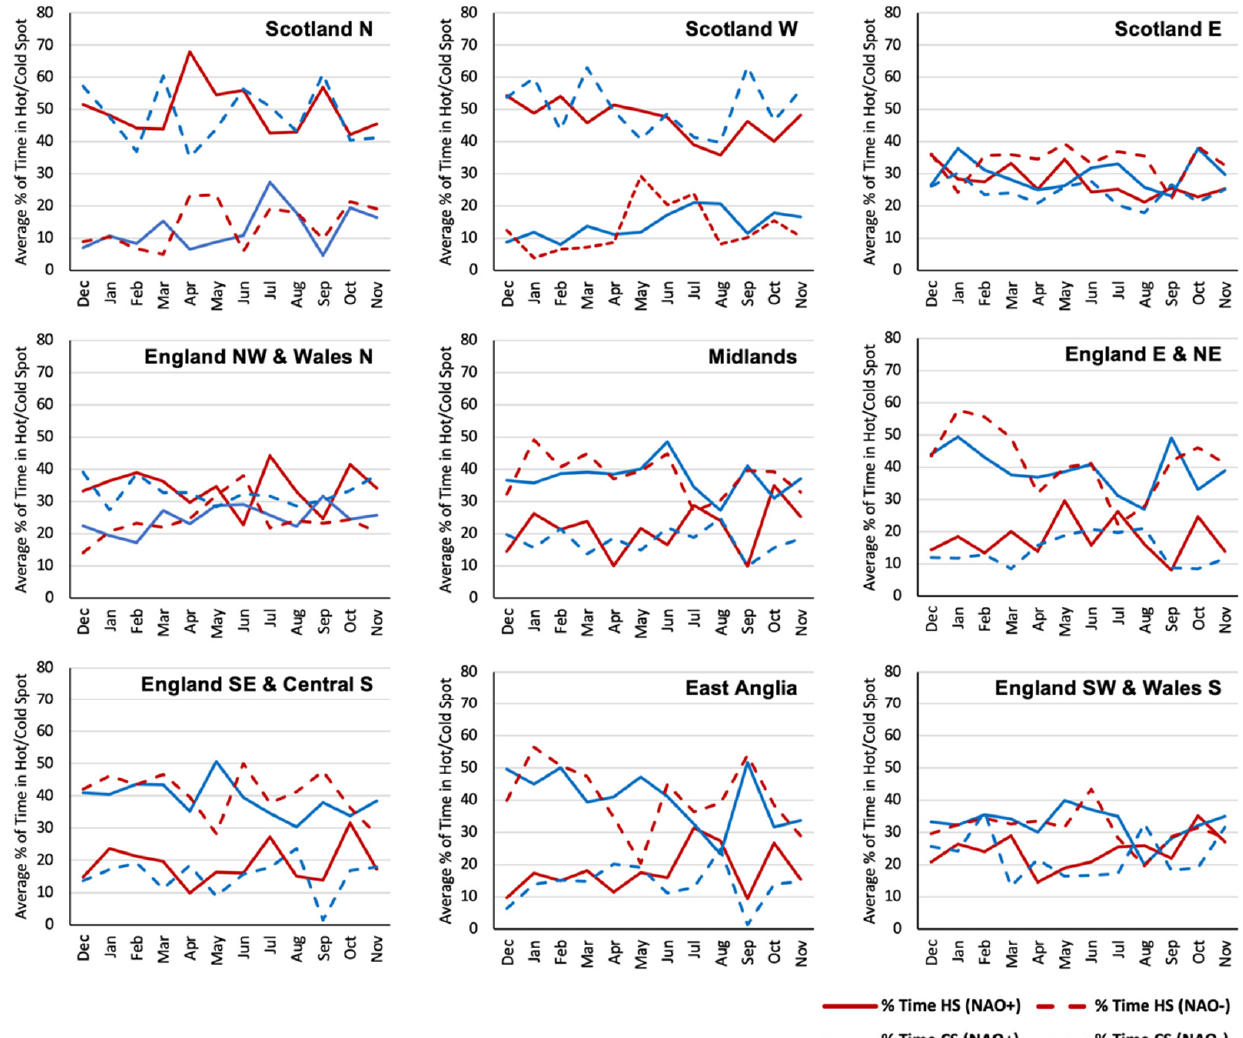
Figure 6. Regional average percentage of time in a significant hot/cold spot (based on the mapped results in Figures 4 and 5). Regions based on the Met Office Climate Districts for Great Britain.